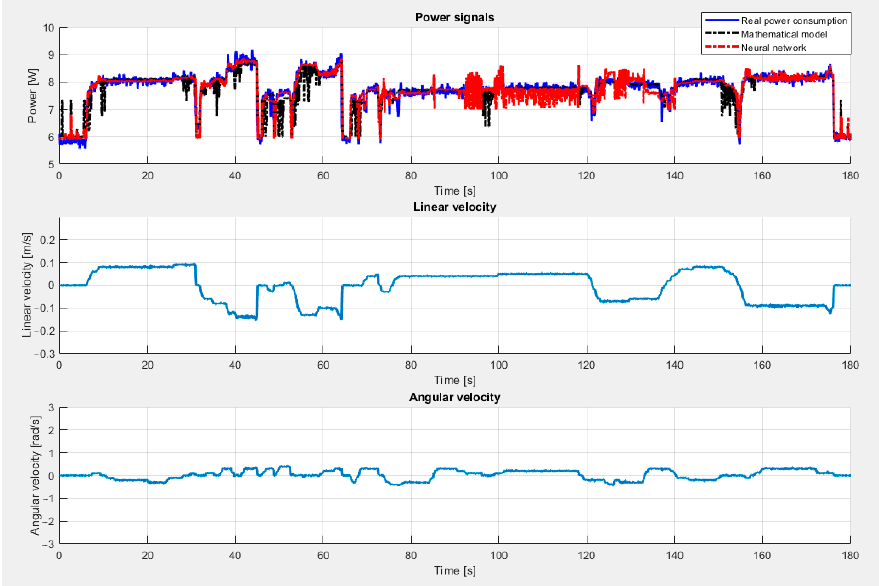
Figure 9. The comparison of the real and estimated power calculated by mathematical model and neural network on the Floor Panels.